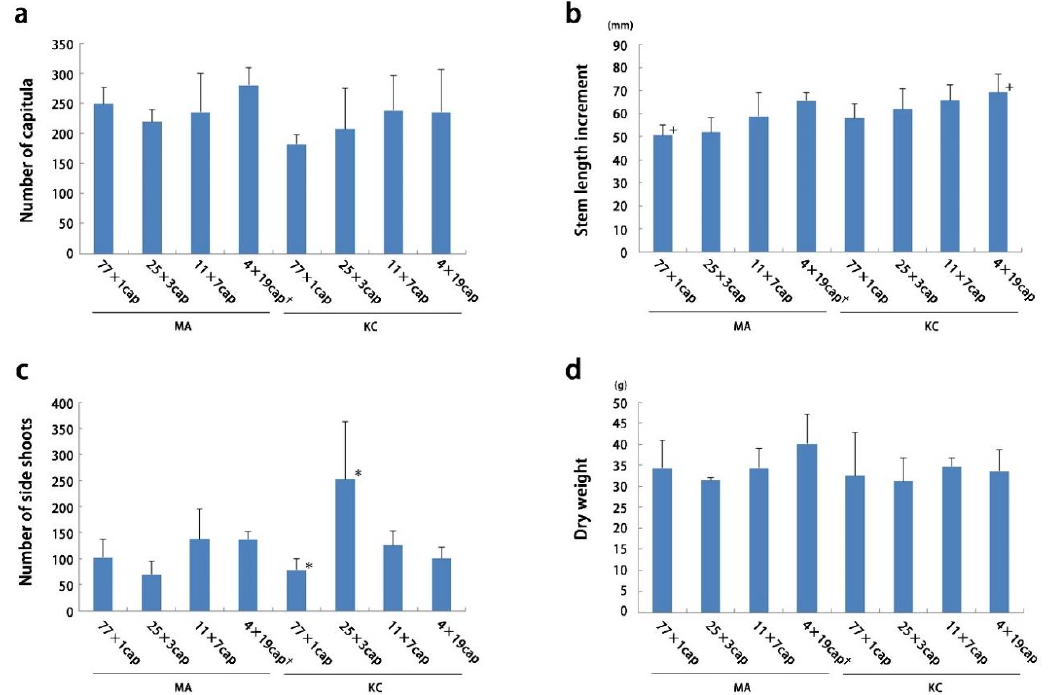
Figure 7. Mean v alues of number of capitula (a), stem length increment (b), number of side shoots (c) and dry weight (d) for sets of 76 ± 1 Sphagnum palustre capitula grown in floating culture at the MA (Mount Aso) and KC (Kumamoto City) experimental sites using four different planting treatments (horizontal axis) replicated three times, at the end of the 2008 growing season (April to November). One replica of the ‘4×19cap’ planting treatment at MA, marked with daggers (†), was removed from the calculations of mean values because the colonies suffered animal damage. Vertical bars indicate SD of mean. Plus (+) and asterisk (*) indicate significant differences (one-way ANOVA test) at p < 0.1 and p < 0.05,